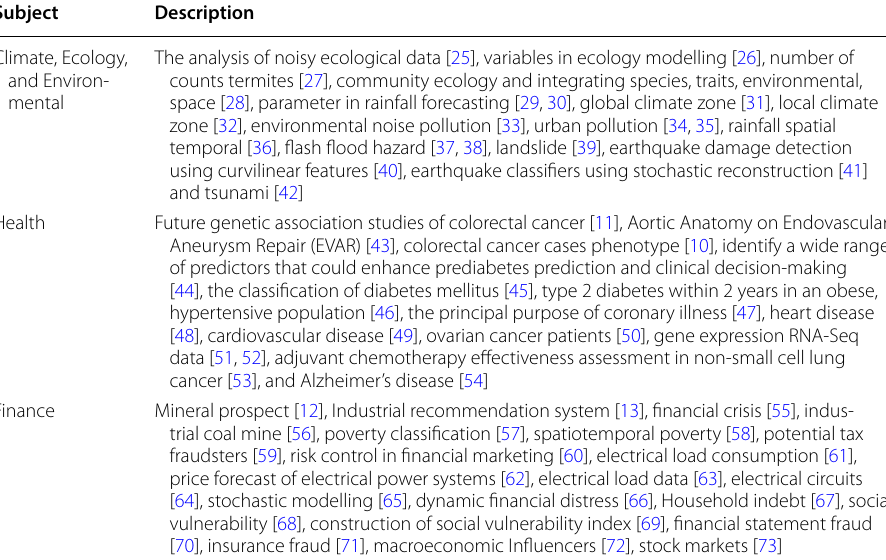
Table 1 Description application of feature